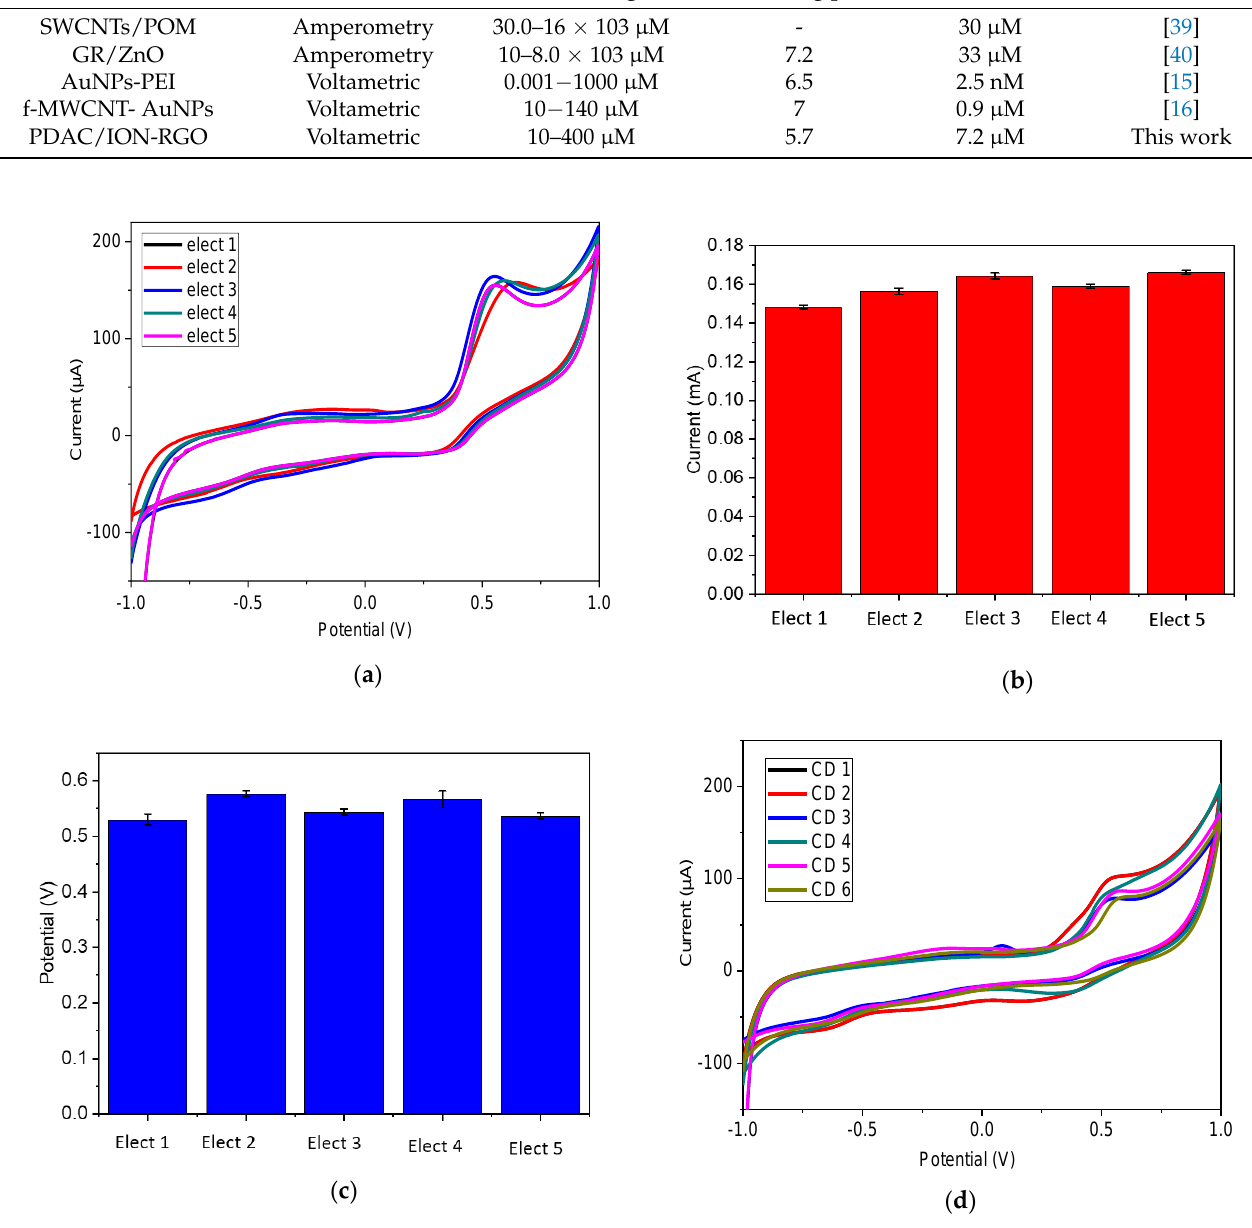
Figure 12. ( a ) cyclic voltammograms of NO 2- detection at pH = 5.7 with a scan rate of 50 mV/s for five electrodes. ( b ) Bar chart of current response for five electrodes. ( c ) Bar chart of potential response. ( d ) Cyclic voltammograms of NO 2 − detection from six different CDs under the same conditions.